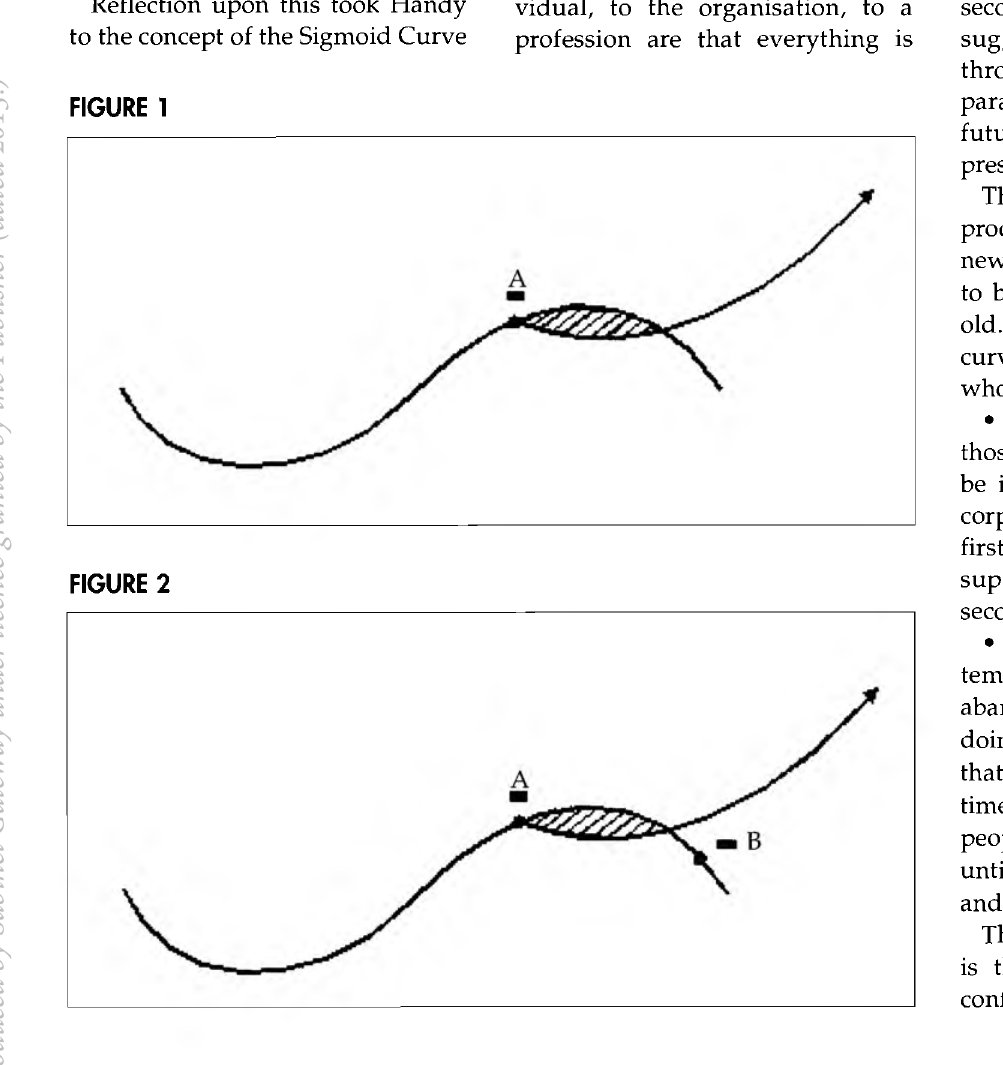
SA J ournal of P hysiotherapy 1998 V ol 54 No